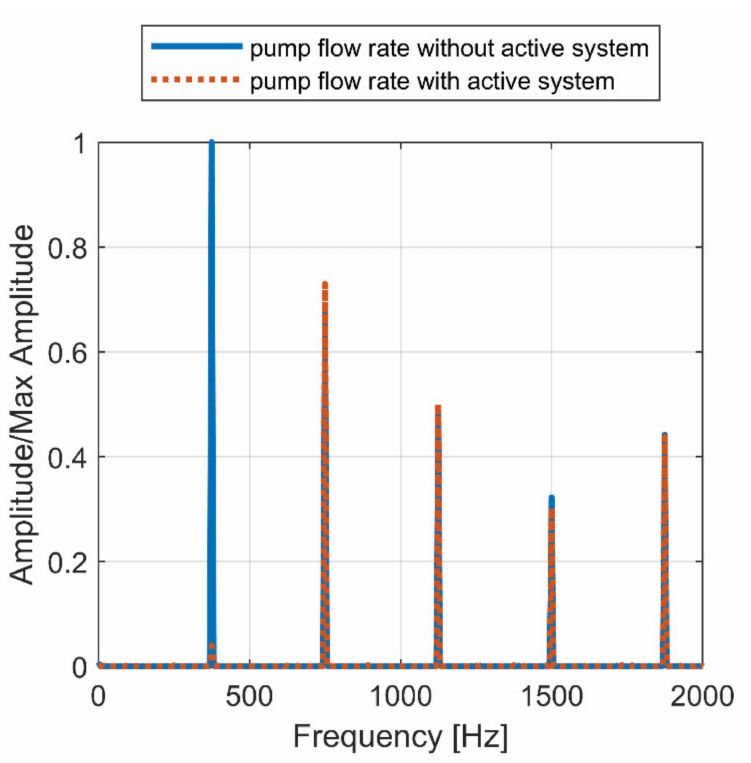
Figure 23. Simulation cycle 1, section 2: flow ripple FFT at 135 bar, 2500 rpm, 100% swash plate